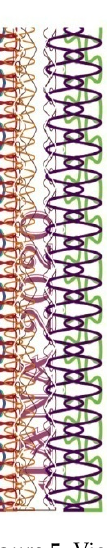
Figure 5. Vignette, security graphic. Figure 6 is composed of alphanumeric characters. Each letter and number is a sepa- rate font that has 30 different values of thickness. An alphanumeric character is a simula- tion of a raster (screen) form, and it simulates the portrait en face from Figure 4. The text creates a surface with micro-text that can often be found in the design of securities. Here the text is connected to the information about the person: name and surname, date, place and country of birth (Figure 6). The fourth picture (Figure 7) is a profile of that same per- son. The pictures are diverse; they derive from vector graphics, pixel graphics or a com- bination. All the colors are set in the RGB system of colors (only the region visible to our eyes).